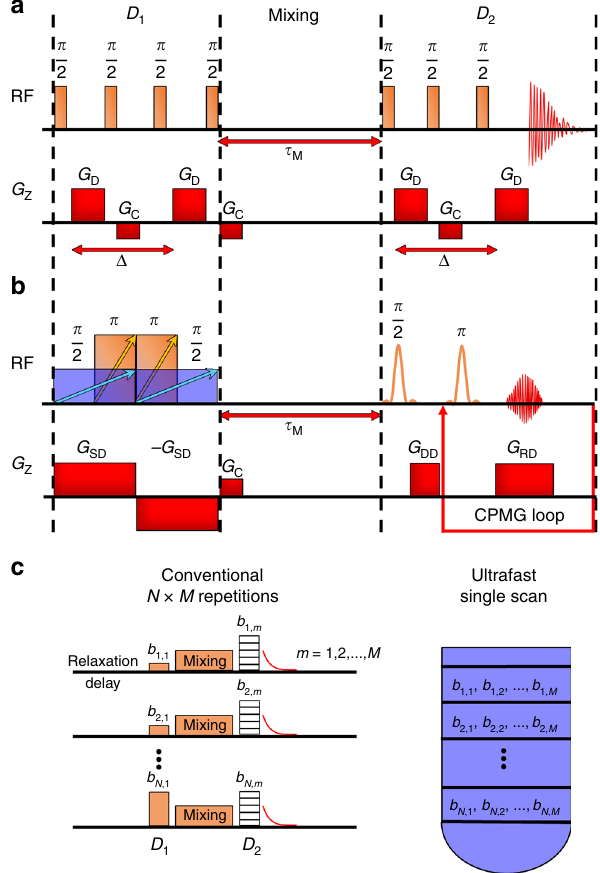
Fig. 1 Diffusion NMR based measurements of molecular exchange. The pulse sequences for ( a ) conventional and ( b ) ultrafast diffusion exchange spectroscopy (DEXSY) measurements. The conventional experiment is repeated multiple times with varying diffusion gradient strength G D (changed independently for periods D 1 and D 2 ), while the same data is measured in a single scan by the ultrafast approach. D 1 and D 2 refer to the fi rst and second diffusion encoding periods, τ M to the mixing time, RF to the radio frequency pulse, G to the gradient pulse, and Δ to the diffusion delay. Subscripts D, C, SD, DD, and RD of G stand for diffusion, crusher, spatial and diffusion encoding, diffusion and dephasing, and read and diffusion, respectively. The arrows overlaying the RF pulses show the direction of frequency sweep. c Illustration of the main difference between the conventional and ultrafast approach. In the conventional experiment, N and M data points, corresponding to the indirect and direct dimension ( D 1 and D b values (which are proportional to the 2 ) and characterized by different gradient strength), are collected in separate experiments, leading to N × M repetitions. In the ultrafast experiment, the same data is spatially encoded into the layers of the sample in a single